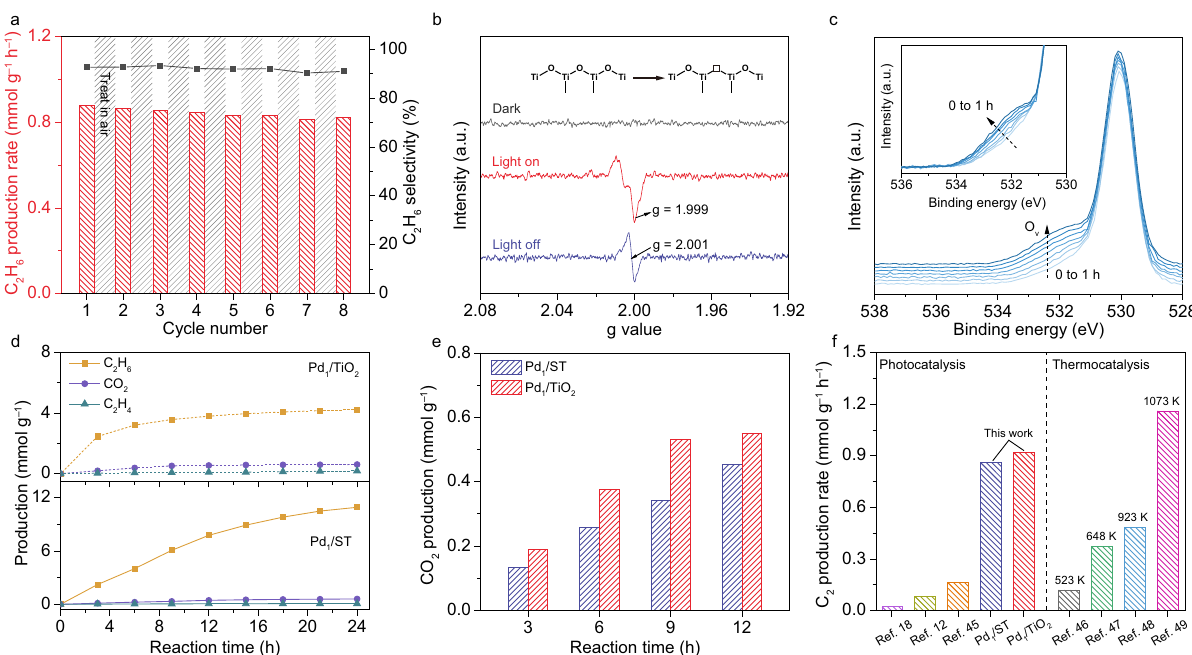
Fig. 5 Evidence and prevention strategy for lattice oxygen consumption. a Production rates and selectivity of C 2 H 6 in the cyclic tests by Pd 1 /TiO 2 . Each cycle lasts 3 h, between which the catalyst is treated in air. b In situ EPR signals for Pd 1 /TiO 2 catalyst in 0.1 MPa CH 4 under different conditions. The inset is the formation of O vacancy during the reaction. c In situ high-resolution O 1 s XPS spectra for Pd 1 /TiO 2 catalyst with different light illumination time in 45 Pa CH 4 . d , e The comparison of C 2 H 6 ( d ) and CO 2 ( e ) production between Pd 1 /TiO 2 and Pd 1 /ST. f The photocatalytic NOCM by Pd 1 /ST and Pd 1 /TiO 2 benchmarked against the photocatalytic NOCM and the mild-condition thermocatalytic NOCM in literature. The temperatures in thermocatalysis represent the reaction temperatures applied in those